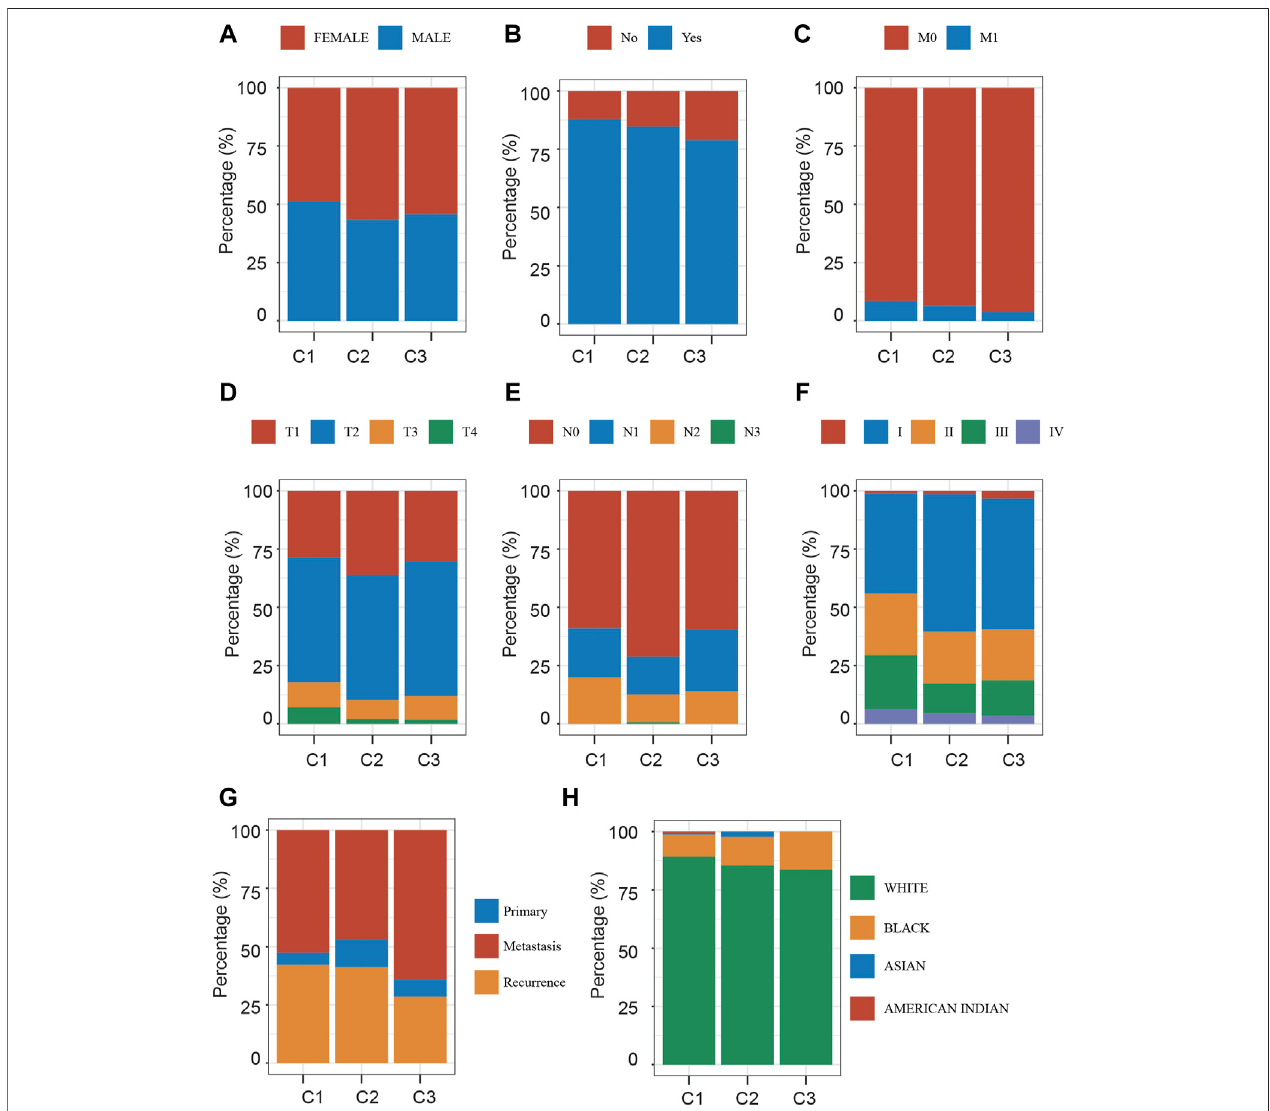
FIGURE 4 | Clinical Characteristics Analysis of Different Stress Granule Subtypes. (A) The distribution of gender in Different Stress Granule Related Subtypes of NSCLCwasshown. (B) ThedistributionofsmokingstatusinDifferentStressGranulerelatedSubtypesofNSCLCwasshown. (C) ThedistributionofMstageinDifferent Stress Granule related Subtypes of NSCLC was shown. (D) The distribution of T stage in Different Stress Granule related Subtypes of NSCLC was shown. (E) The distributionofNstageinDifferentStressGranulerelated SubtypesofNSCLCwasshown. (F) Thedistribution ofgradeinDifferentStressGranulerelated Subtypes ofNSCLCwasshown. (G) ThedistributionofmetastasisstatusinDifferentStressGranulerelatedSubtypesofNSCLCwasshown. (H) ThedistributionofraceinDifferent Stress Granule related Subtypes of NSCLC was shown.